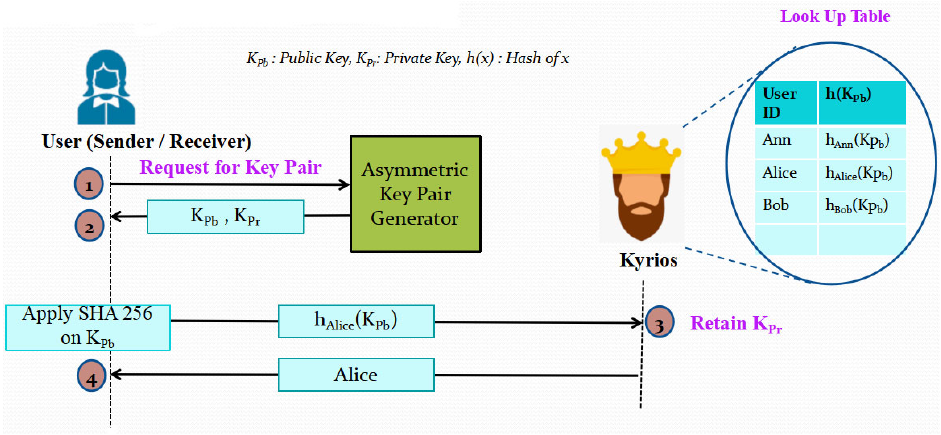
Figure 2. Illustration of Phase 1: Registration Process.